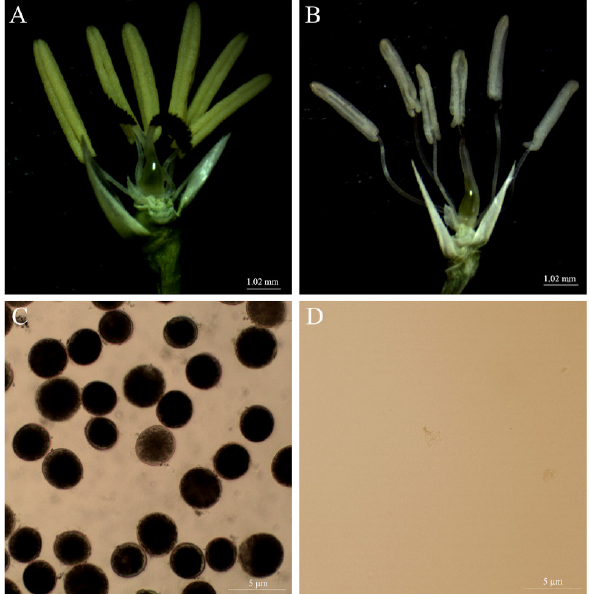
Figure 1. Cytological observation of pollen morphology. ( A ) The anthers of WXS (F) were full under the low temperature (~22 ◦ C) and shorter day lengths, and ( C ) the pollen grains of WXS (F) yellow and full under the low temperature (~ 22 °C) and shorter day lengths, and ( C ) the were deeply stained by iodine-potassium iodide (I 2 -KI). However, ( B ) the anthers of WXS (S) were pollen grains of WXS (F) were deeply stained by iodine-potassium iodide (I 2 -KI). However, white and shriveled under higher temperatures ( > 23 ◦ C) and longer day lengths, and ( D ) the pollen ( B ) the anthers of WXS (S) were white and shriveled under higher temperatures (> 23 °C) grains of the WXS(S) were completely and longer day lengths, and ( D ) the pollen grains of the WXS(S) were completely absent.